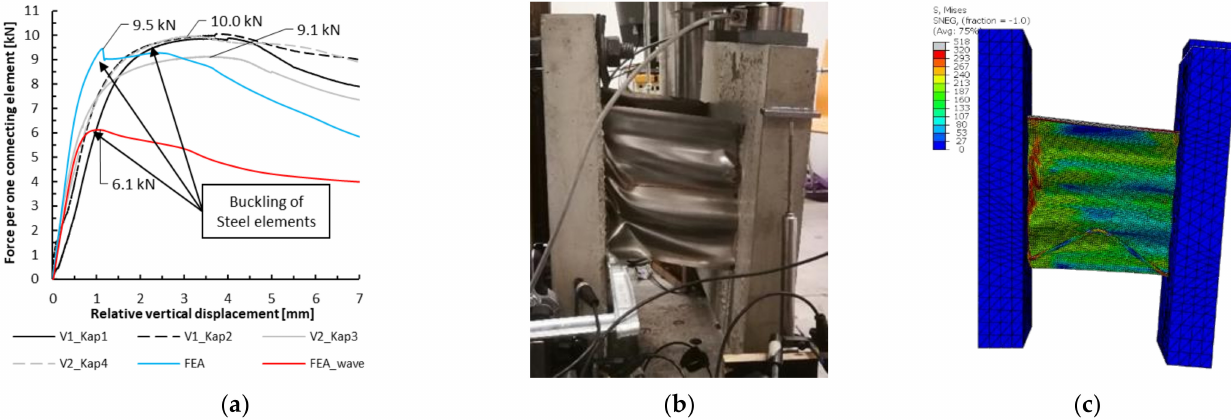
Figure 7. Test results KAP-steel-connector double wall elements: ( a ) load-deformation diagram with results from laboratory tests (black and grey) and FEA-simulations (blue and red); ( b ) specimen post failure in the laboratory test; ( c ) finite element specimen post failure, deformation superelevated two